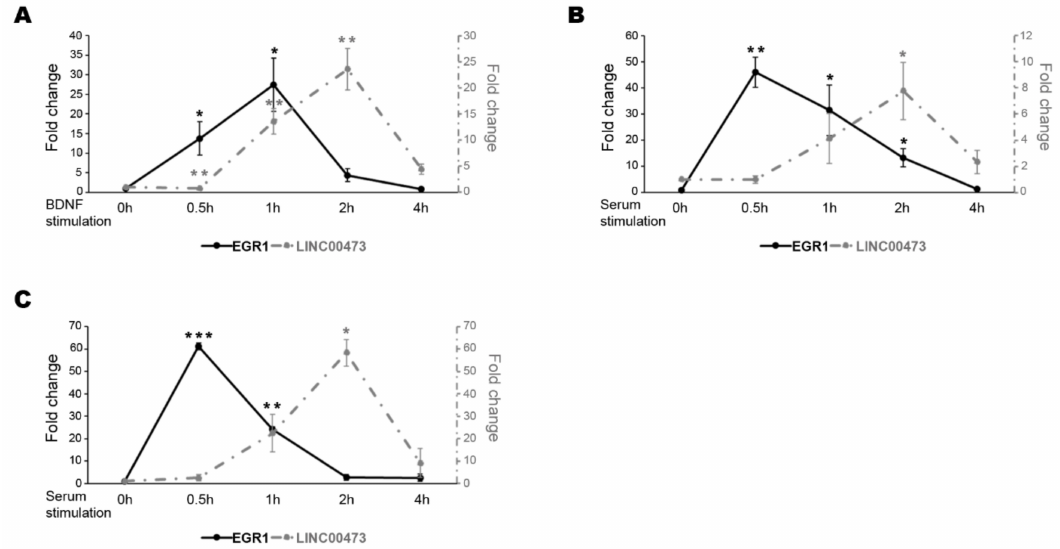
Figure 1. Expression pattern comparison of EGR1 and LINC00473 under BDNF stimulation. Expression level change in N-enriched SH-SY5Y cells after BDNF stimulation ( A ), in N-enriched SH-SY5Y cells after serum stimulation ( B ), and in HEK293T cells after serum stimulation ( C ) at the indicated time points for EGR1 (black line) and LINC00473 (dashed grey line). The sample at time 0 h was used as the calibrator. Gene expression levels were normalized to the reference gene Glyceraldehyde-3-phosphate dehydrogenase (GAPDH) and calculated by the 2 − ∆∆ Ct method. The results from independent biological replicates are expressed as mean of fold change ± SEM. Statistical analysis of the qPCR data was carried out using a two-tailed t-test. Significance of di ff erence from time 0 h (* p ≤ 0.05, ** p ≤ 0.001, *** p ≤ 0.0001) is shown.